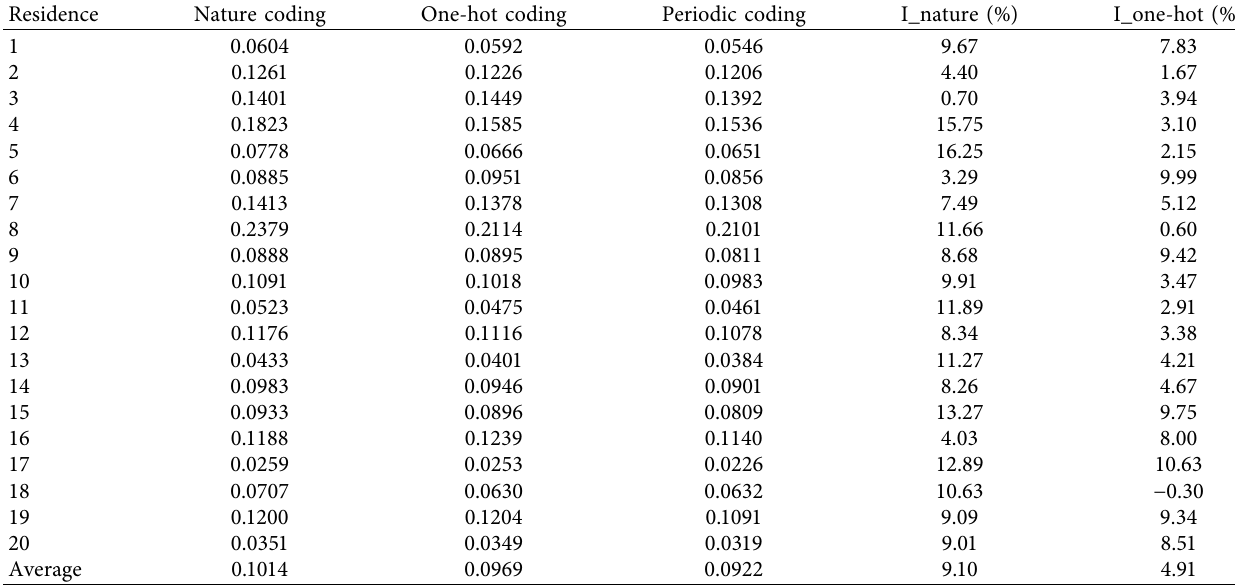
Figure 12: Forecasting results and ground truth of residence 2 for one week. X -axis expresses time with a half-hour unit, and Y -axis represents electricity load. Eight intervals between 0.1 and 0.9 are shown in different colors, where the solid black lines represent the ground truth. (a) QGBRT, (b) QCNN, (c) QLSTM, and (d) our proposed model. Table 4: AQS comparison of three time-coding